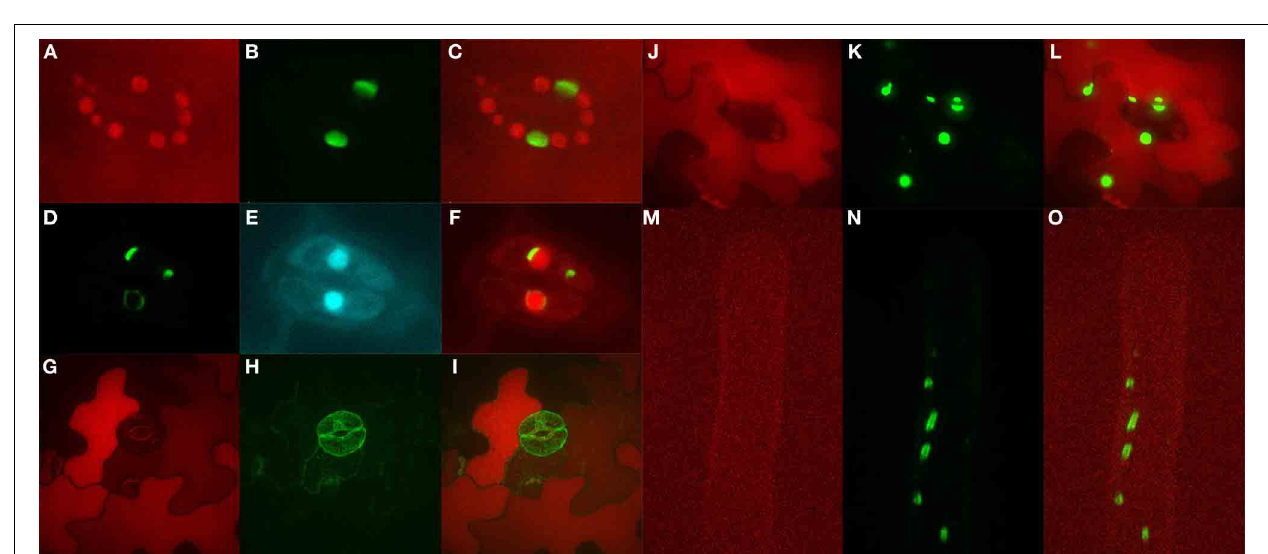
FIGURE 5 | Subcellular localization of AtYSL6 in stably transformed plants. The AtYSL6-GFPmid construct, controlled by a ubiquitin promoter, was stably transformed into Arabidopsis plants. (A) Red fluorescence of guard cell chloroplasts. (B) Green fluorescence in guard cells from (A) . (C) Overlay of (A,B). (D) Green fluorescence in guard cells. (E) DAPI fluorescence in guard cells from (D) . (F)